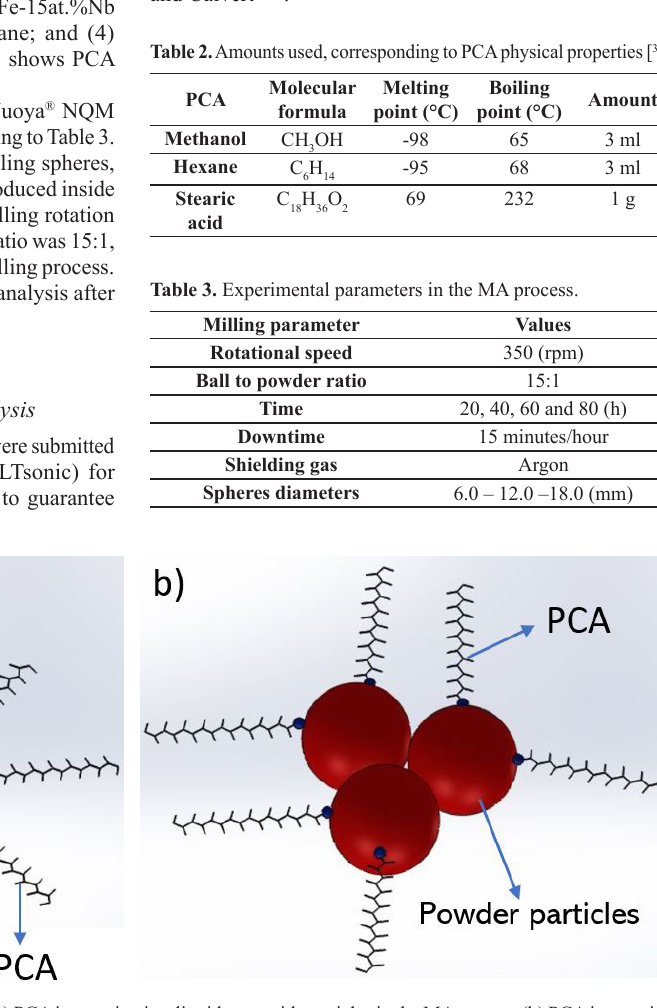
Figure 3. Schematic of PCA absorption difference (a) PCA interaction in a liquid state with particles in the MA process (b) PCA interaction in a solid state with particles in the MA process.